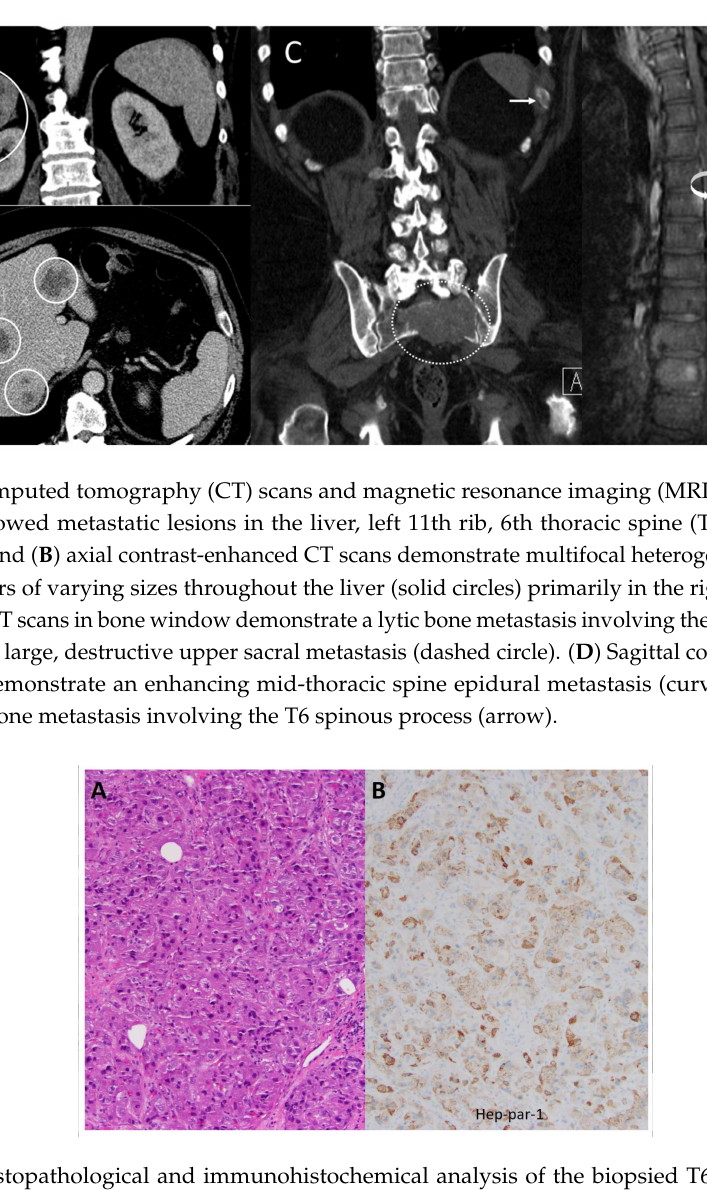
Figure 2. Histopathological and immunohistochemical analysis of the biopsied T6 epidural mass. ( A ) The hematoxylin- and eosin-stained section shows infiltration by nests of polygonal cells with enlarged atypical nuclei and abundant eosinophilic cytoplasm. Nuclear pseudo-inclusion and mitotic figures are apparent. ( B ) Immunohistochemical analysis for Hep-Par-1 shows granular cytoplasmic staining, supporting a diagnosis of metastatic hepatocellular carcinoma (original magnification ×